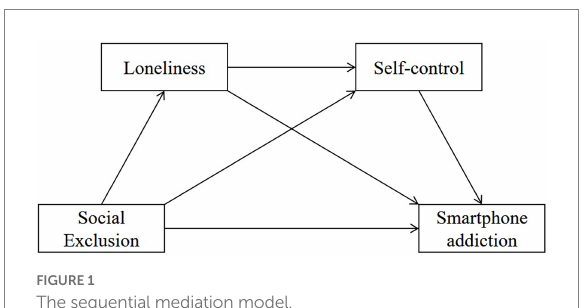
FIGURE 1 The sequential mediation